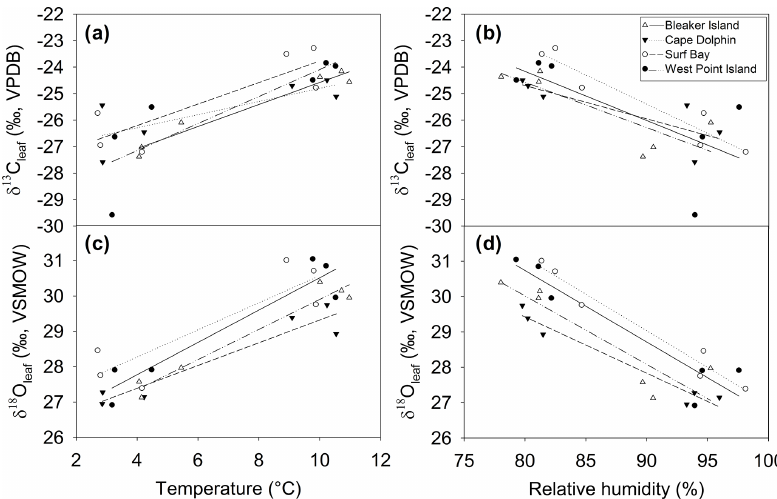
Figure 7. Relationship between δ 13 C leaf and δ 18 O leaf and temperature and relative humidity during winter and summer at four sites. Rela- tionship between δ 13 C leaf , (a) temperature, and (b) humidity. Relationship between δ 18 O leaf , (c) temperature, and (d) humidity. See Table 1 for Pearson’s r and p values corresponding to correlations for each